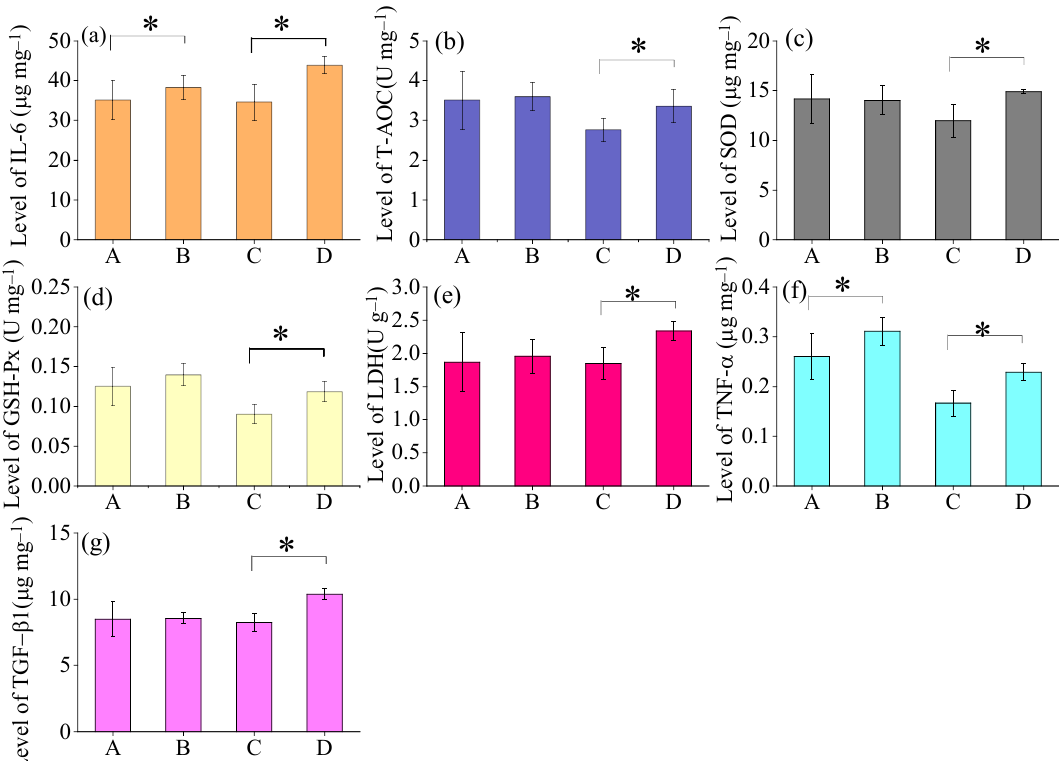
Figure 3. Changes in levels of inflammatory factors of mice lungs among different groups after 6months of exposure to ambient air: A. Male Group A ( n =5), B. Male Group B ( n =5), C. Female Group A ( n =5), D. Female Group B ( n =5). ( a ) IL-6, ( b ) T-AOC, ( c ) SOD, ( d ) GSH-Px, ( e ) LDH, ( f ) TNF- α , and ( g ) TGF- β 1 * Means within two groups are significantly different at p < 0.05 (Student’s t -test).